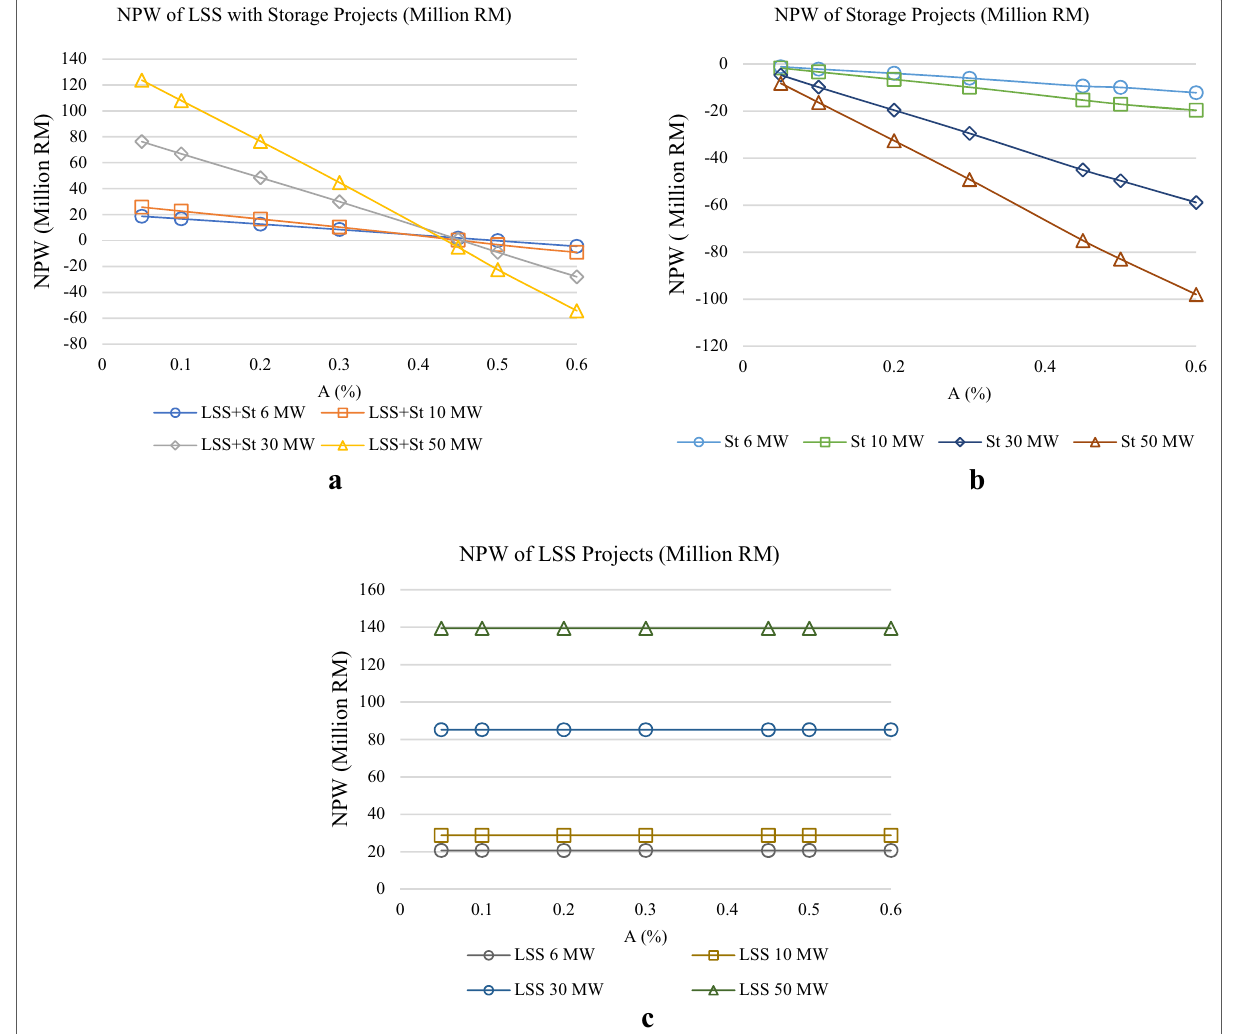
Fig. 3 Net present worth of different LSS capacities with variation of “ A ” in Pahang. a LSS with storage projects, b storage projects, c LSS